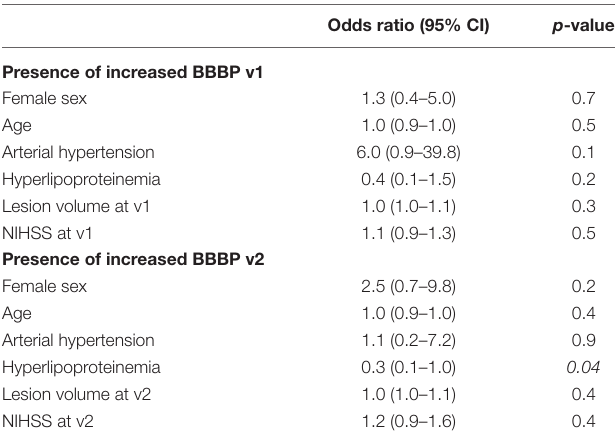
TABLE 3 | Multivariate regression analyses of factors associated with presence of increased BBBP before (v1) and after (v2) intervention.